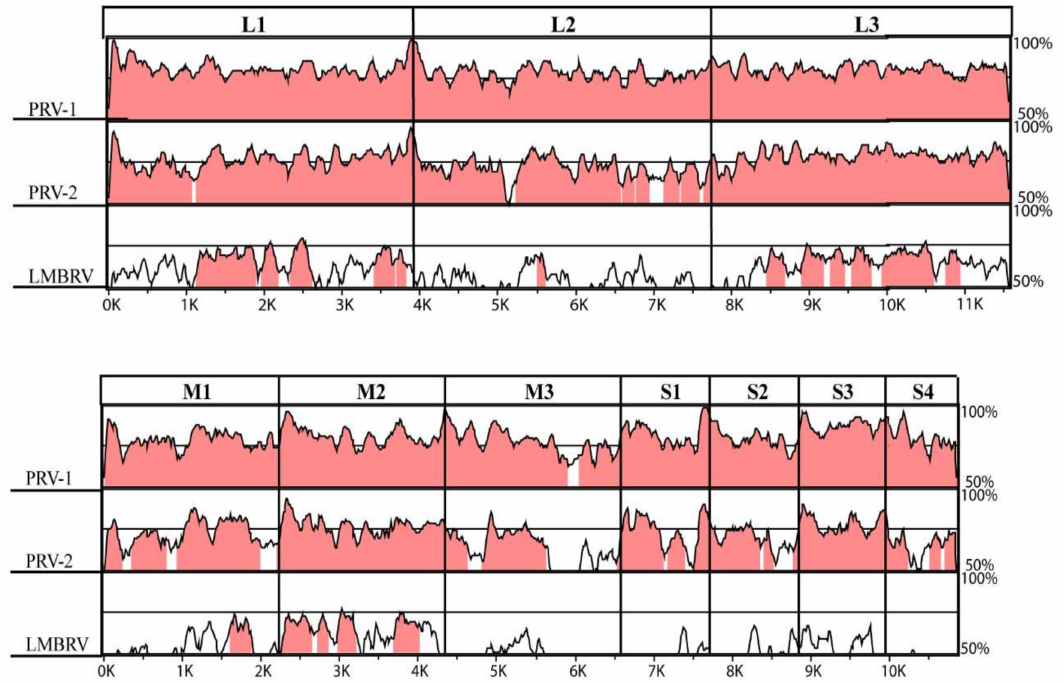
Figure 2. Stacked pair-wise conservation profile analysis. PRV-3 was used as a base sequence in an mVISTA alignment comparing whole genome segments with PRV-1, PRV-2, and LMBRV. Areas in pink colored regions illustrate >70% identities. The X -axis indicates the nucleotide sequence length in kb. Pairwise nucleotide- and amino acid sequence identities between PRV-1 and -3 were 80.1% (segment range 76.5–87.9%) and 90.5% (79.1–96.7%) for the nucleotide and the amino acid sequences, respectively. For PRV-3 versus PRV-2, the corresponding values were 72.9% (62.6–78.3%) and 80.0% (59.7–93.0%), respectively (Table 1). The amino acid identities of PRV-1 and PRV-3 were higher than the nucleotide identities for all the proteins, except σ 3 and